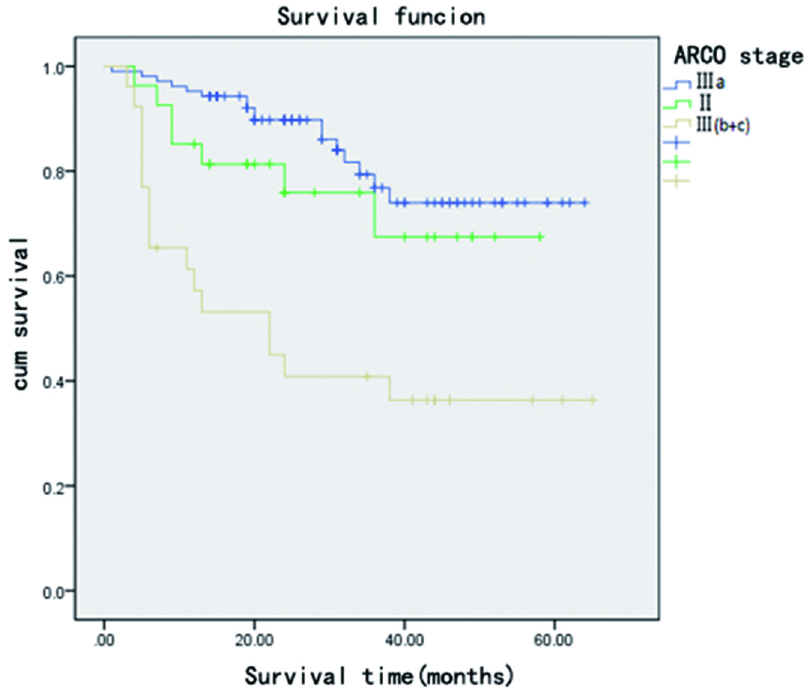
Fig 1. Kaplan – Meier survival curve shows that patients aged 40 and above had worse postoperative prognosis than patients aged under 40.